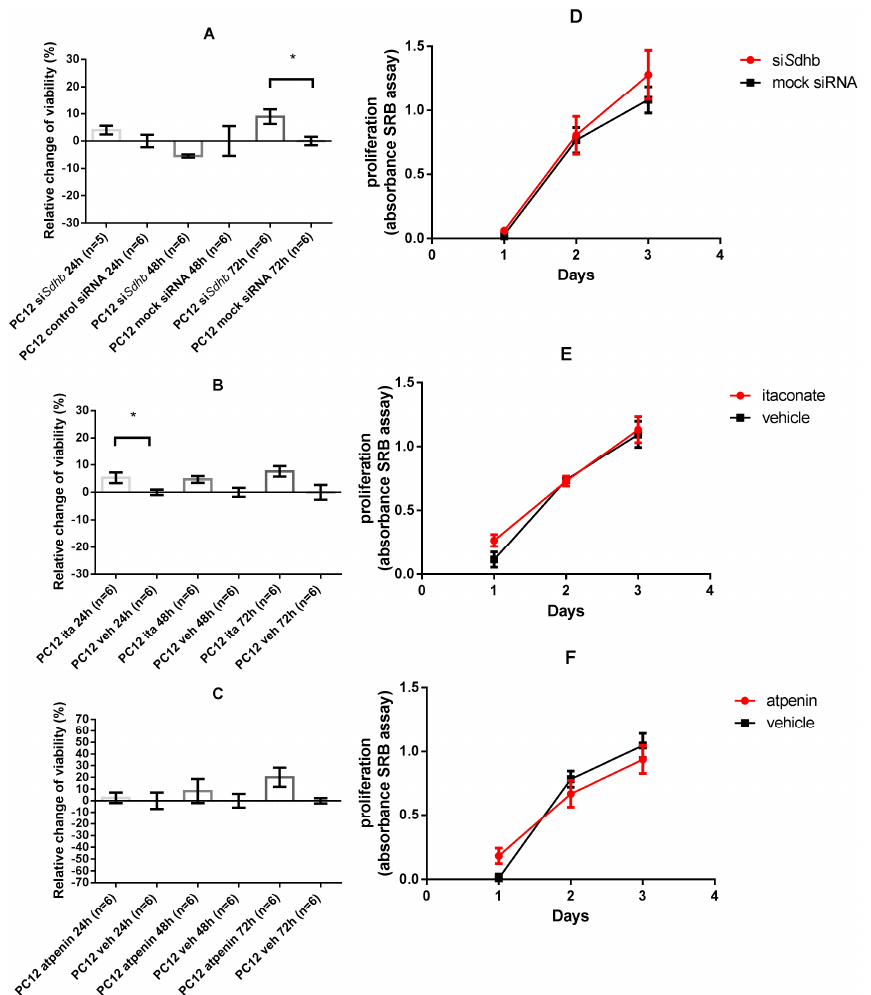
Figure 2. Cell viability and proliferation of PC12 cell lines. Data is presented in mean ± SEM. Cell viability measurement values are normalized to the control values. A total of 100% was subtracted from the values, therefore, changes in % compared to control are presented. ( A – C ) Relative change of cell viability of Sdhb targeting siRNA transfected, itaconate, or atpenin treated PC12 cells after 24, 48, and 72 h incubation, compared to control. ( D – F ) Proliferation of PC12 cells after Sdhb targeting siRNA transfection, itaconate, or atpenin treatment measured by SRB assay. Ita: Itaconate; veh: vehicle. SRB: Sulforhodamine B; *: p <